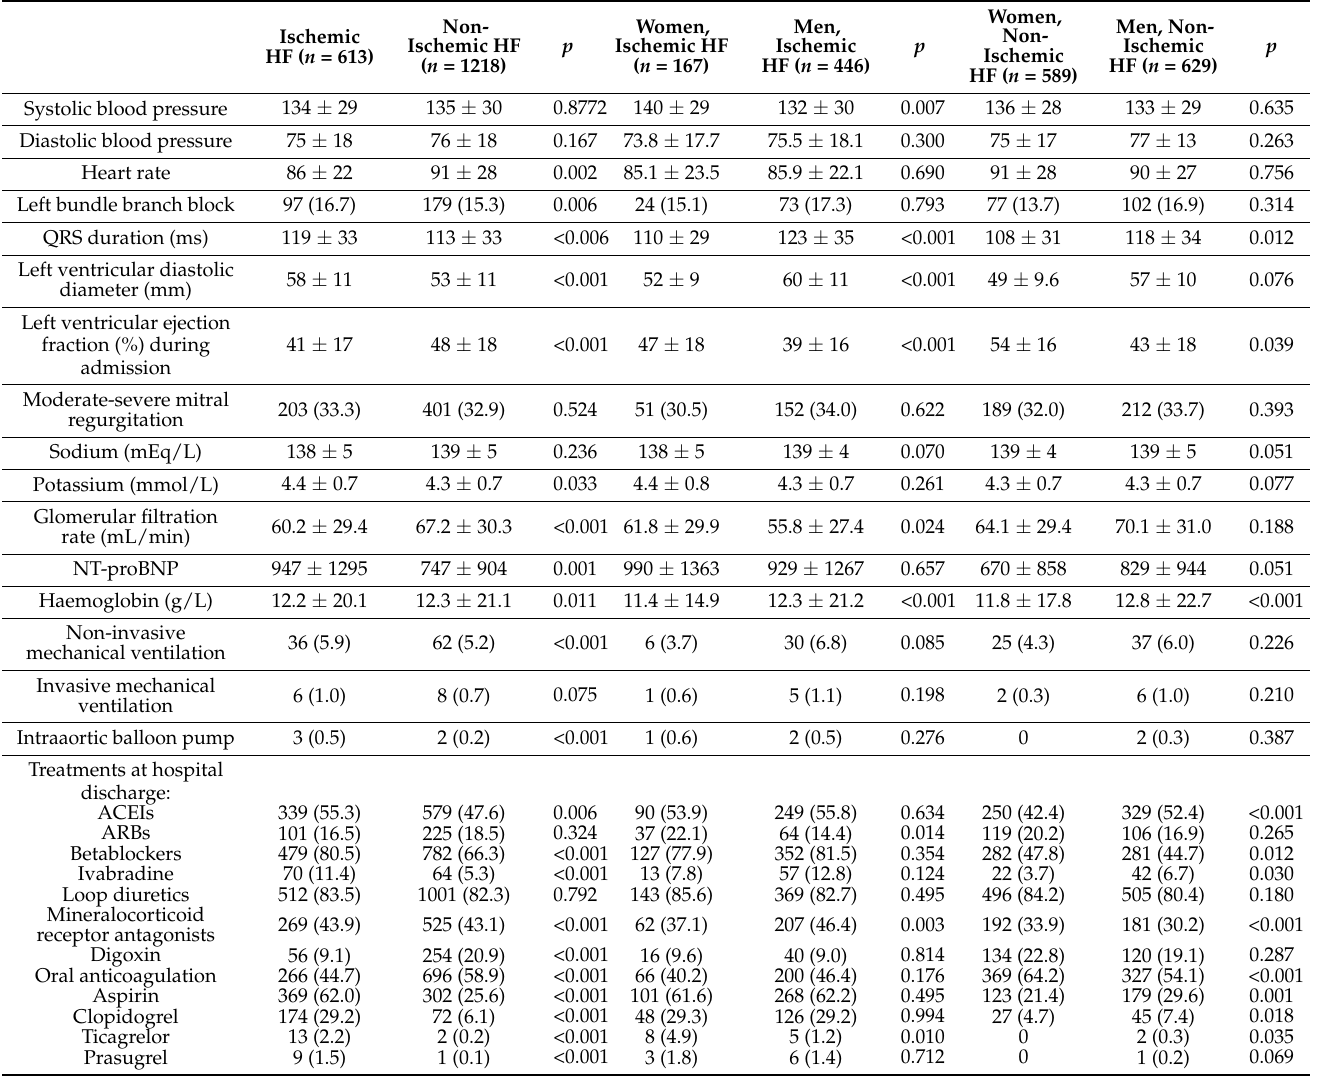
Table 2. Vital signs at admission and in-hospital treatments in patients with heart failure (HF) according to etiology and sex.